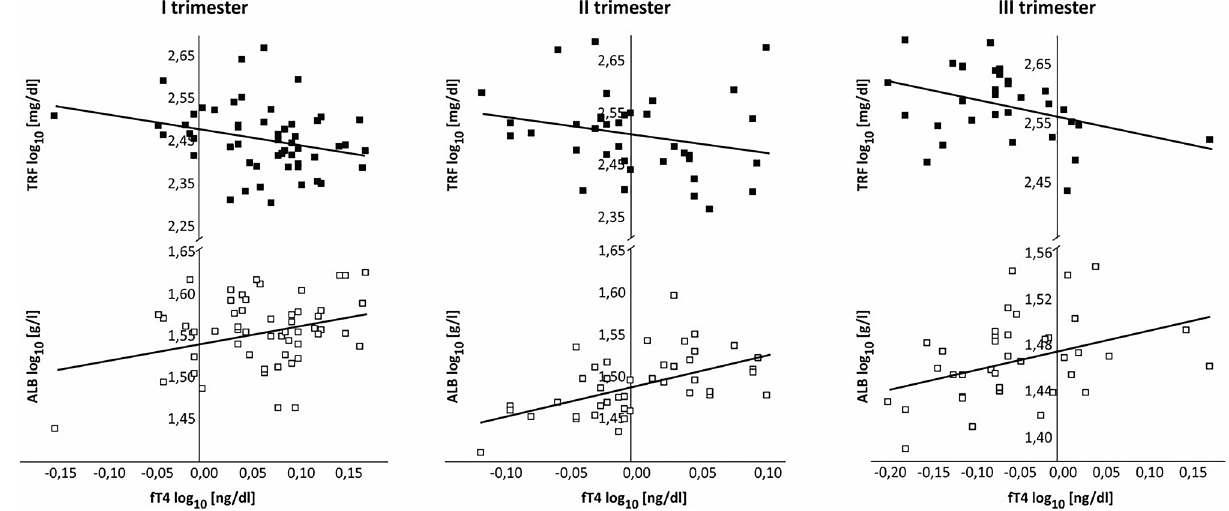
Figure 1. Correlations between concentrations of fT4 and of ALB (open square) and TRF (filled square) in maternal serum across